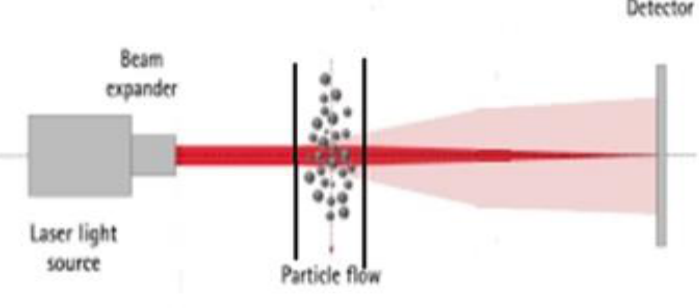
Figure 2: Simplified diagram of the pollutant detection